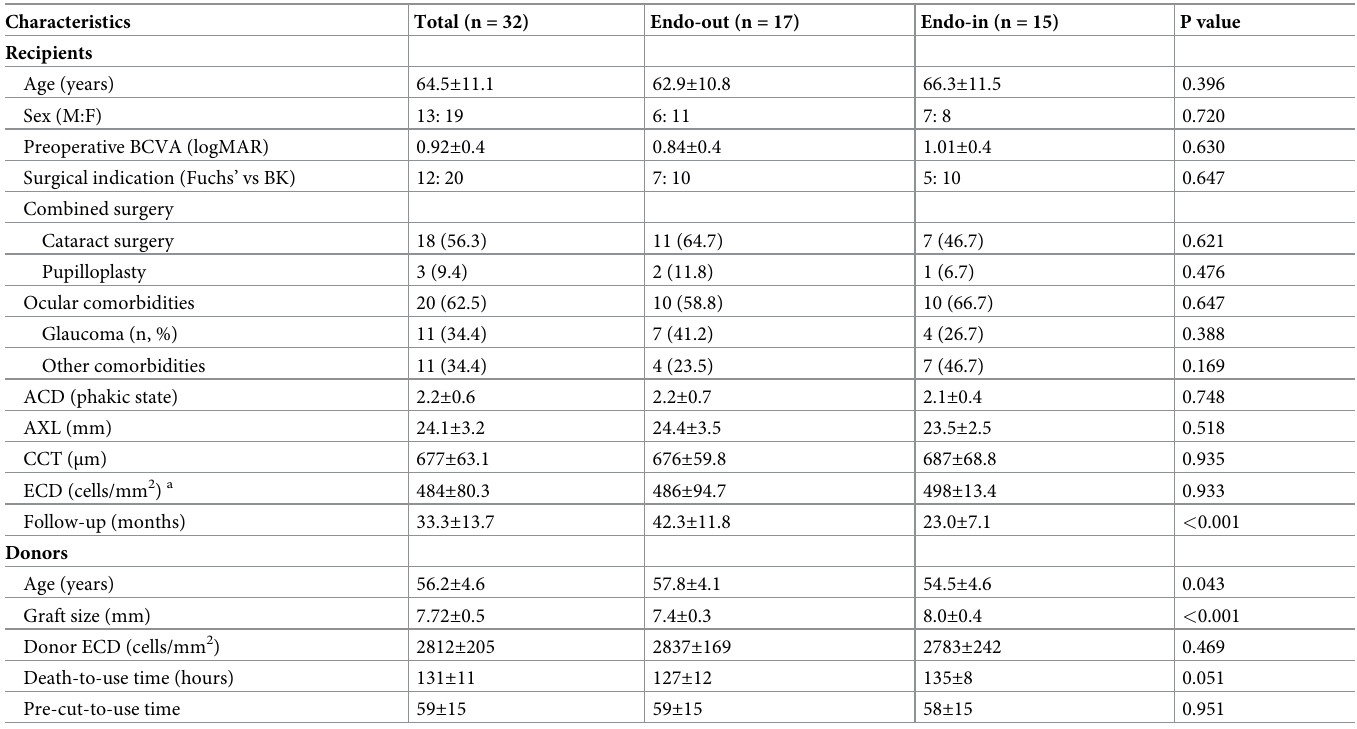
Table 1. Preoperative demographics in recipients and donors.